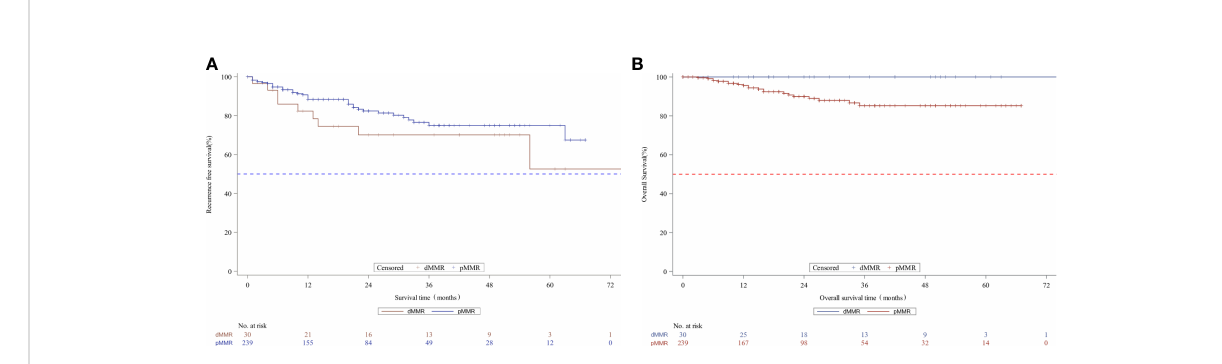
FIGURE 1 Kaplan-Meier curves for recurrence-free survival (A) and overall survival (B) according to MMR status in the whole unmatched patients. MMR denotes mismatch repair, dMMRdefective MMR; pMMRpro fi